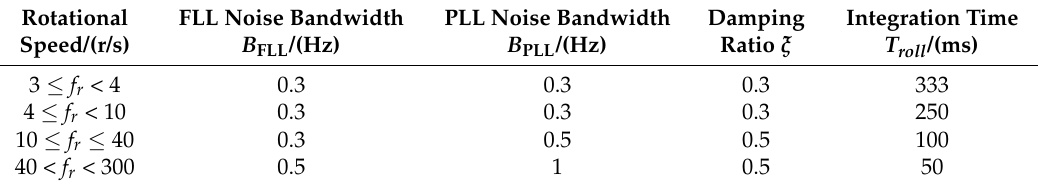
Table 1. Desirable parameters of FLL-assisted PLL.